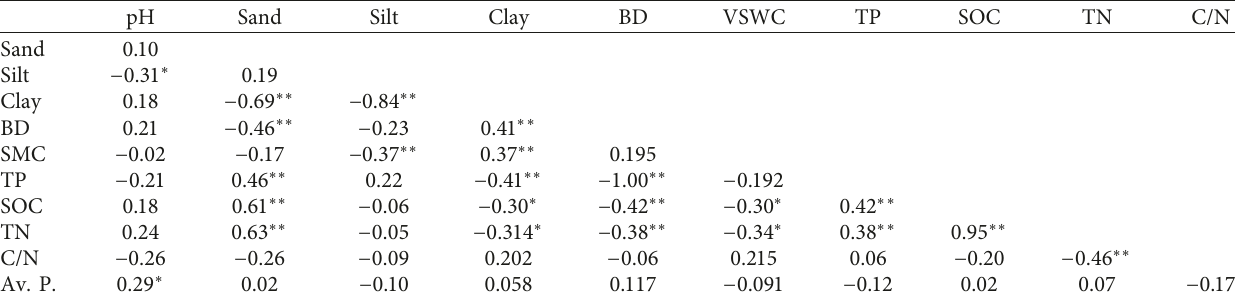
Table 4: Pearson’s correlation coefficient between soil quality indicators of land